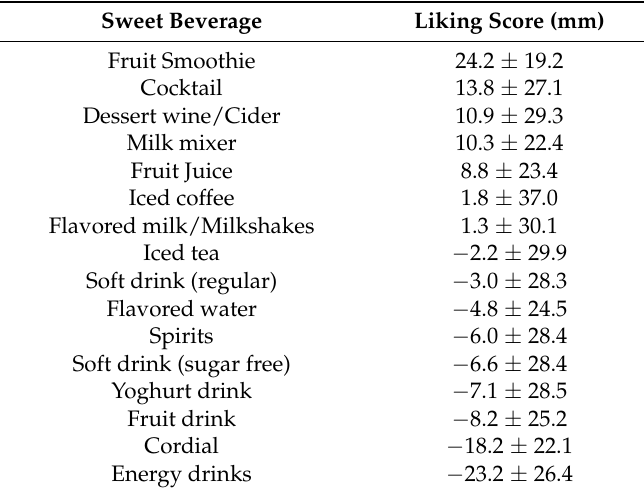
Table 5. Liking scores of sweet beverages.